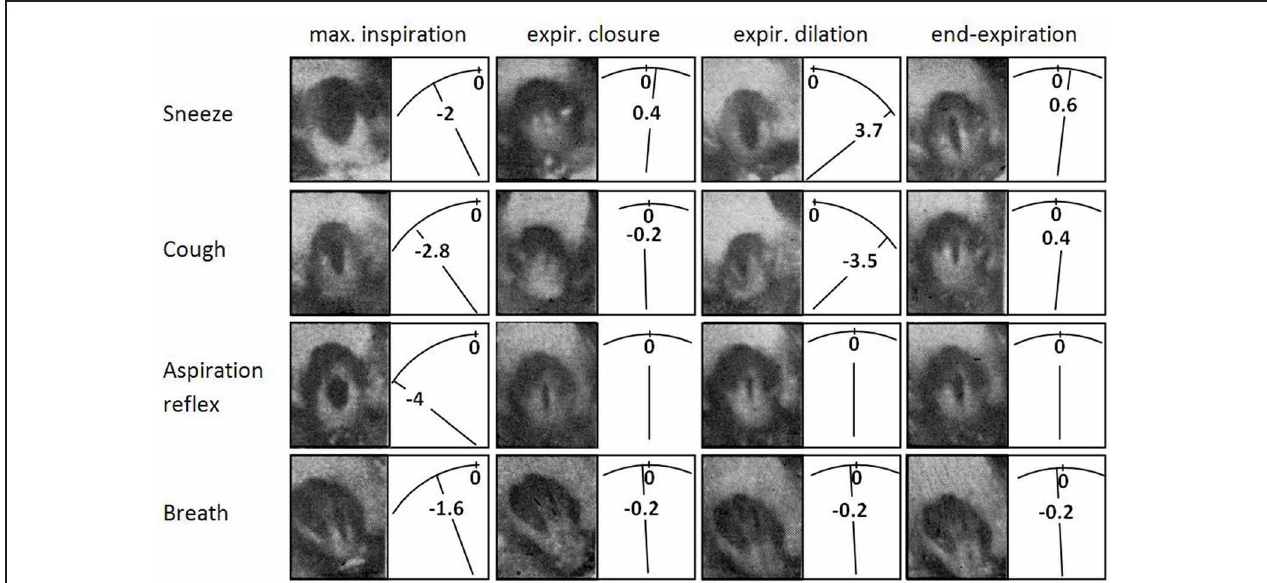
FIGURE 4 | Cine-photographs of glottis in sneeze, cough, AspR, and control breath in a cat. Cine-photographs of glottis in one inspiratory—expiratory cycle of the sneeze, cough from tracheo-bronchial region, aspiration reflex, and control breath in anesthetized cat. Phases illustrated: maximum inspiration, early expiratory glottal closure or narrowing, successive expiratory glottal dilation, and end of expiratory